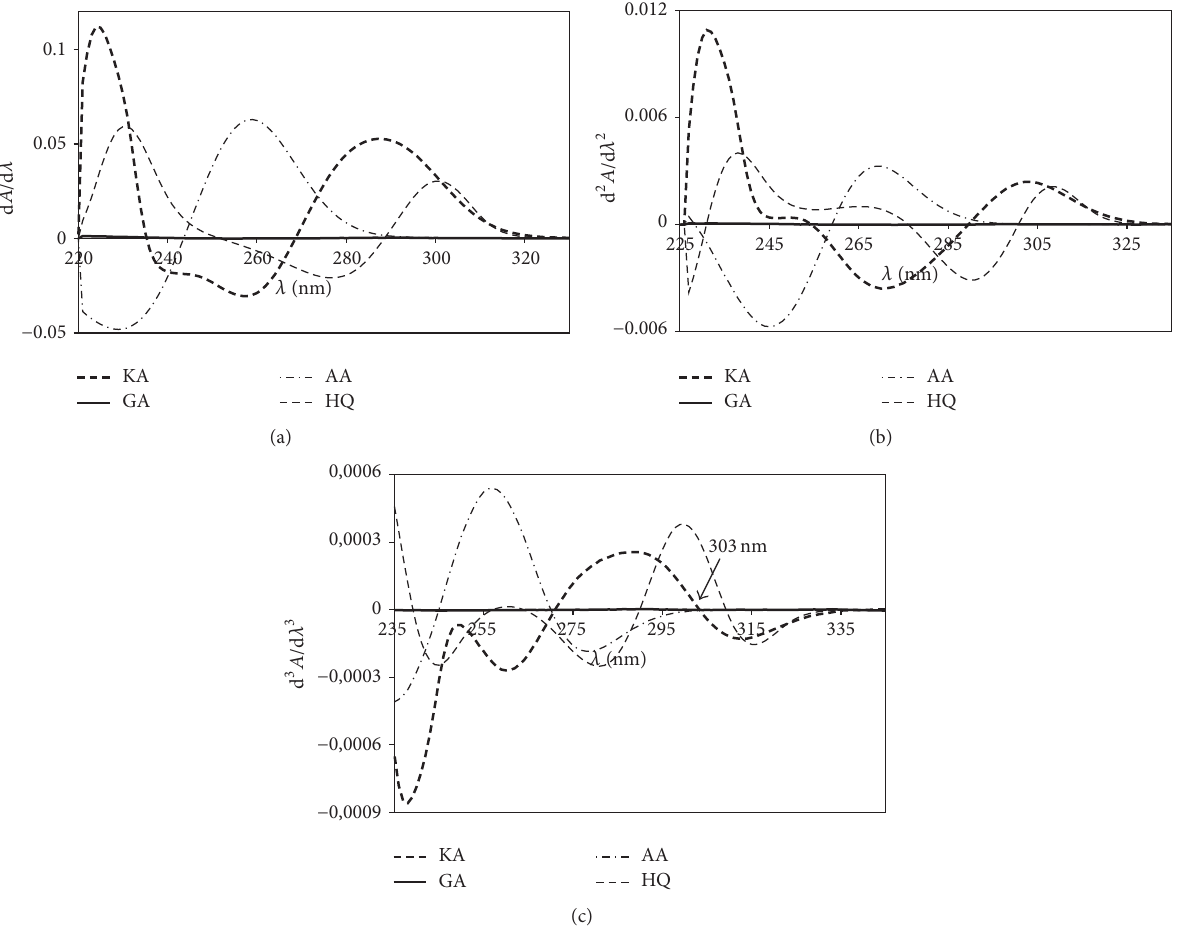
Figure 2: (a) First-order, (b) second-order, and (c) third-order derivative spectra of HQ, KA, AA, and GA; every compound has the same concentration (2 × 10 −4 mol ⋅ L −1 ).